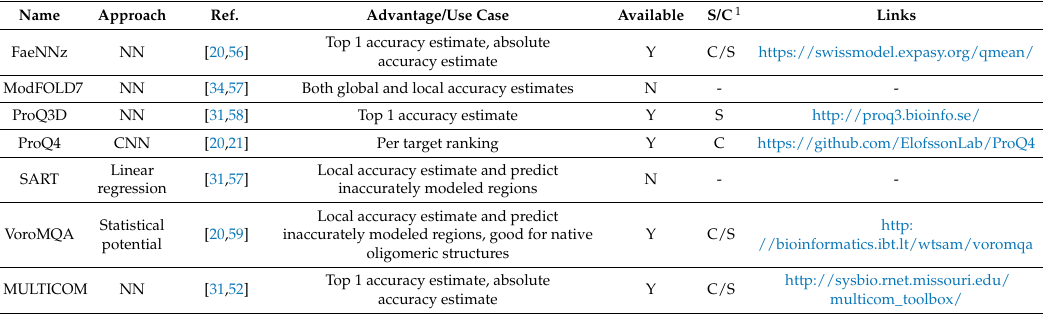
Table 1. Top-performing estimating model accuracy (EMA) methods in CASP13